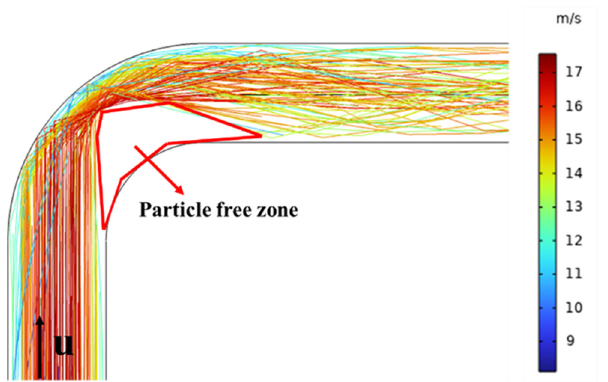
Figure 9. Cross ‐ sectional view of collision trace of particles and elbow and a particle ‐ free region. Figure 9. Cross-sectional view of collision trace of particles and elbow and a particle-free